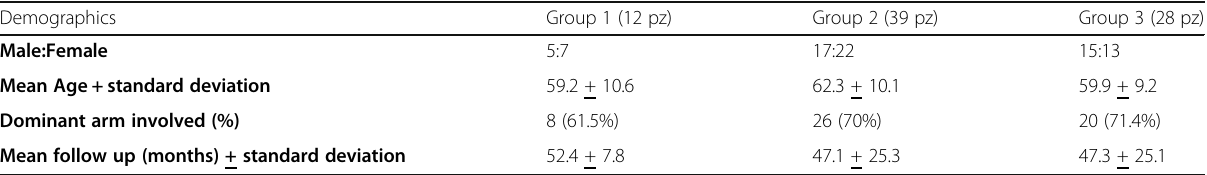
Table 2 Demographic characteristics of the patients